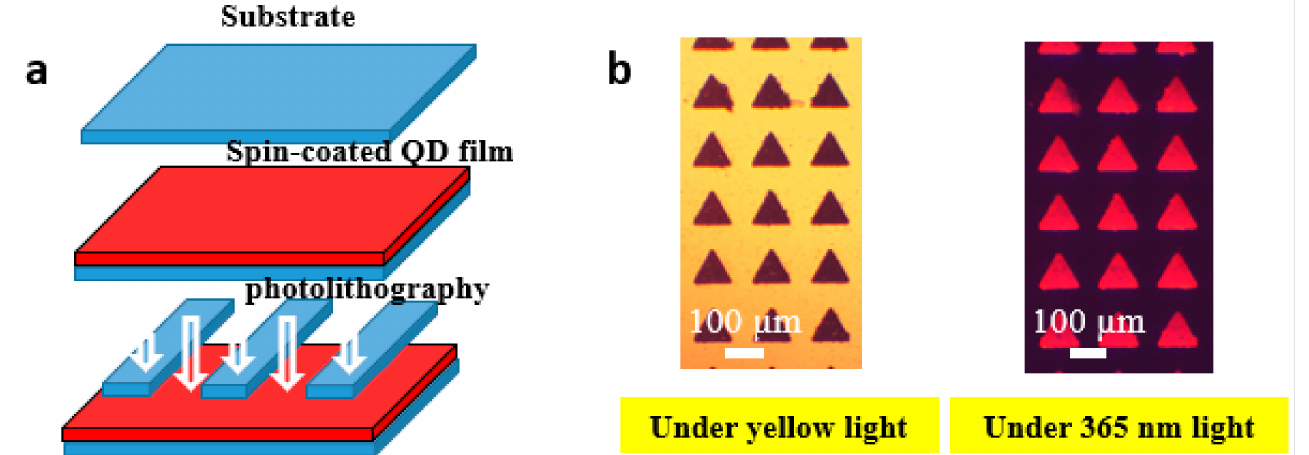
Figure 2. ( a ) The process flow of QDCF by photolithography; ( b ) the photolithography red QDCF after hard baking. Those triangles are the irradiated part, and the rest parts are the nonirradiated